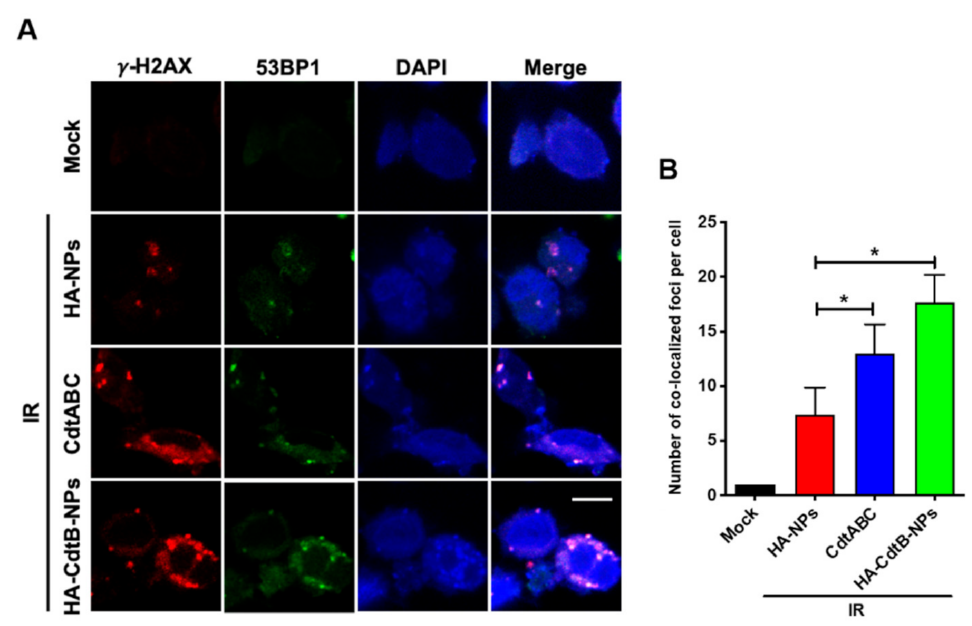
Figure 5. HA-CdtB-NPs sensitize PCa cells to radiation by promoting DSB. PC3-KD cells were mock-treated or exposed to IR (2 Gy) then incubated with 100 nM HA-NPs, CDT holotoxin, and HA- CdtB-NPs for 24 h. ( A ) Fluorescent immunostaining of γ -H2AX (red) and 53BP1 (green) was shown. DAPI (blue) was used as a tracer for cell nucleus. Scale, 10 µ m. ( B ) The foci of γ -H2AX and 53BP1 colocalization in the nuclei were counted. Statistical significance was evaluated using one-way ANOVA with post hoc test (* p <